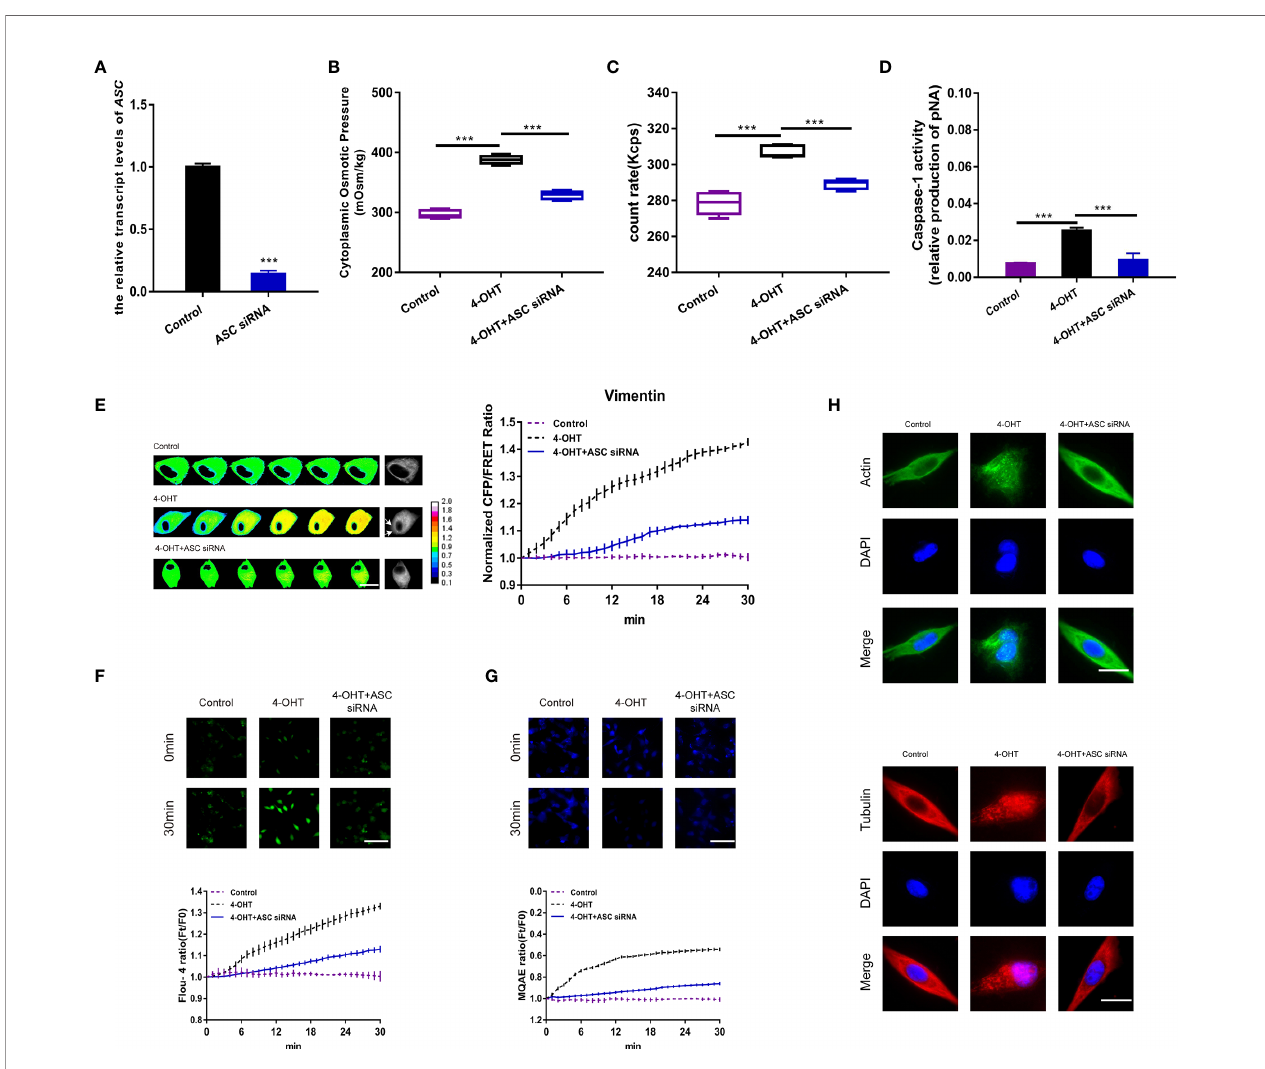
FIGURE 2 | ASC-induced in fl ammasome assembly regulated PN-OP. (A) RT-qPCR was used to measure the relative transcript level of ASC after transient transfection with the ASC siRNA. (B) The cytoplasmic OP values of U87 cells were measured using a freezing point osmometer under co-treatment of 4-OHT with the ASC siRNA. (C) The count rate of PNs. (D) Caspase-1 activity of cells. (E) Representative images and mean values of normalized CFP/FRET ratios of Vimentin tension under the different treatments. Arrows indicate the membrane blebbing regions. The calibration bar was set from 0.1 to 2.0. Scale bar, 10 m m. (F) Calcium imaging micrographs and traces of relative Fluo-4 fl uorescence intensity (Ft/F0) of cells. (G) Chloridion imaging micrographs and traces of relative MQAE fl uorescence intensity (Ft/F0) of cells. The increase of intracellular Cl - levels led to the decrease of MQAE fl uorescence value instead. (H) Monolayers of U87 cells were subjected to 4-OHT treatment alone, or co-treatment with 4-OHT and the ASC siRNA, then stained with b -actin (FITC) or a -tubulin (TRITC). The images were generated from the fl uorescence inverted microscope after immuno fl uorescence staining. Mean of ≥ 3 experiments ± SEM. Values marked with asterisks are signi fi cantly different, as determined using a t